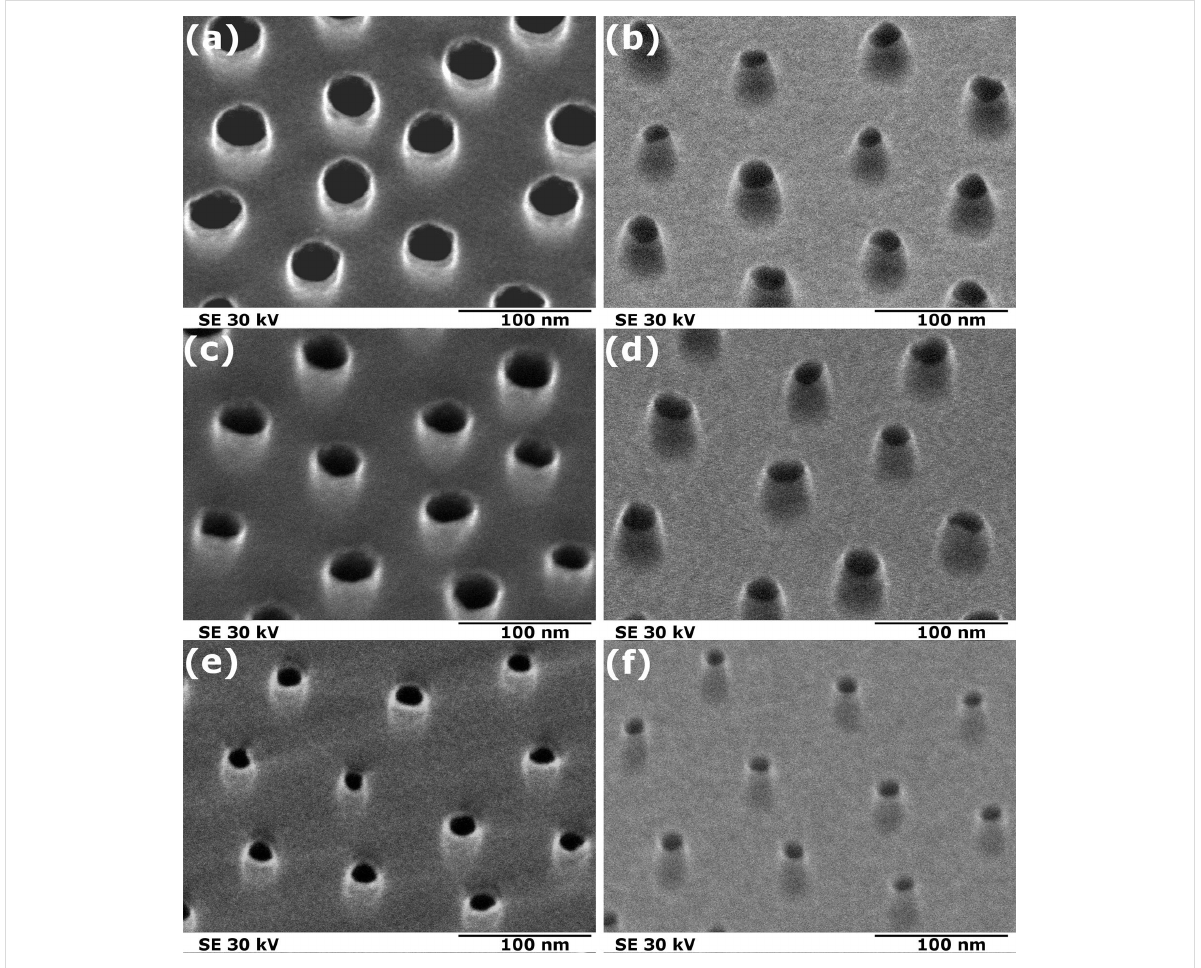
Figure 2: HRSEM micrographs of nanoporous silicon nitride membranes with Cr top layer. Shown are three membranes (A, B, and C) with different average diameters. The left column (a, c, e) presents the top side and the right column (b, d, f) the corresponding bottom side (scale bars: 100 nm). The resulting diameter data are summarized in Table